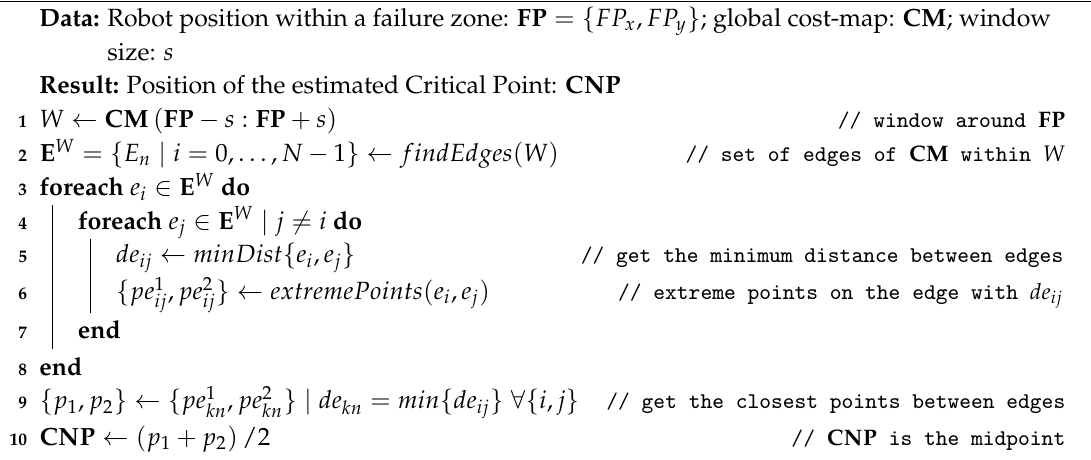
Algorithm 1: Determining the critical points (CNPs)